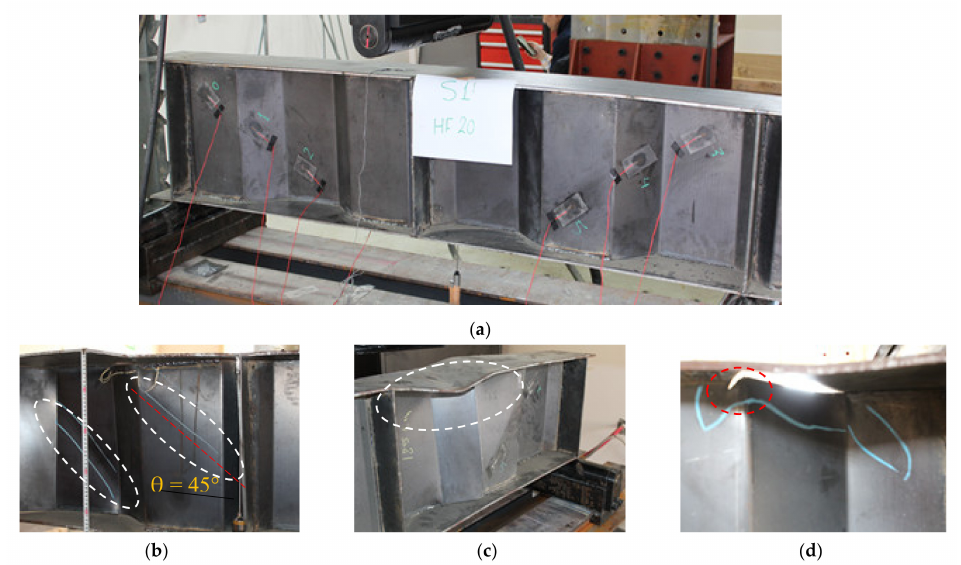
Figure 8. Failure mode of specimen CW20IFNW: ( a ) Specimen CW20IFNW before testing; ( b ) Local web buckling; ( c ) Vertical flange buckling; ( d ) Web tearing.